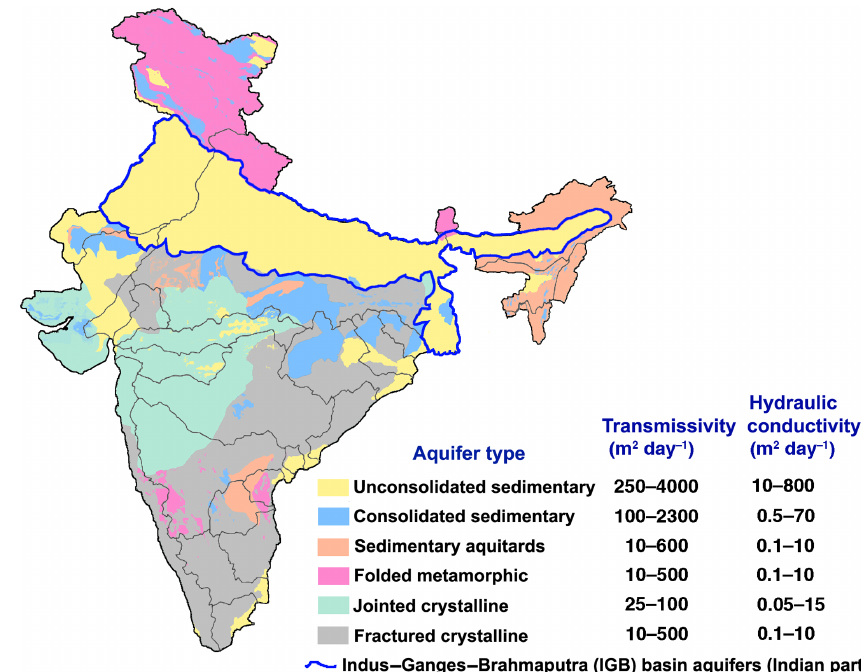
Figure 3. Aquifer types, transmissivity (m 2 day − 1 ) and horizontal hydraulic conductivity values (mday − 1 ). Transmissivity and horizontal hydraulic conductivity values are obtained from the Central Ground Water Board (2012) and Groundwater Resource Estimation Methodology (1997). IGB basin aquifers are shown with blue